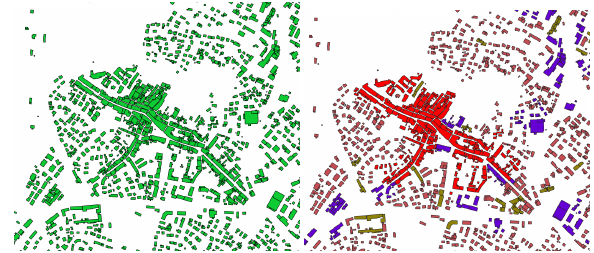
Figure 10. Left: building polygons before classification, right: classified Buildings. Red represents urban area, brown represents high density residential and purple represents industrial and commercial